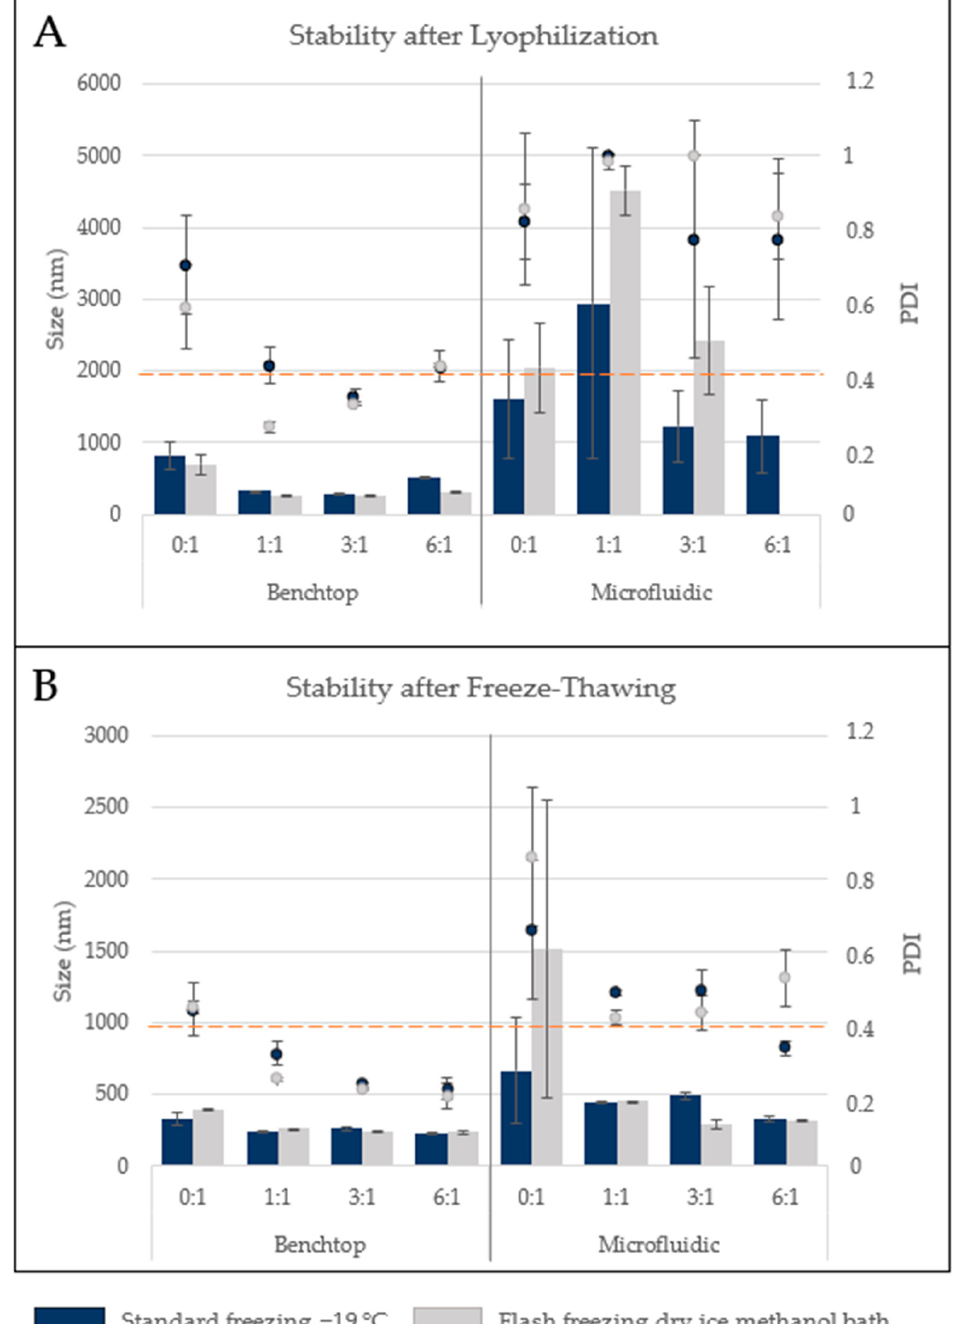
Figure 3. Size and homogeneity analysis of H-NMeds ( A ) after resuspension of lyophilized and ( B ) freeze-thawed aliquots. Bars: Size (nm), Dots: PDI. Blue bars and dots: standard freezing − 19 °C, Grey bars and dots: flash freezing in a dry ice methanol bath. Each value is expressed as the Mean ± SD of three independent formulations.